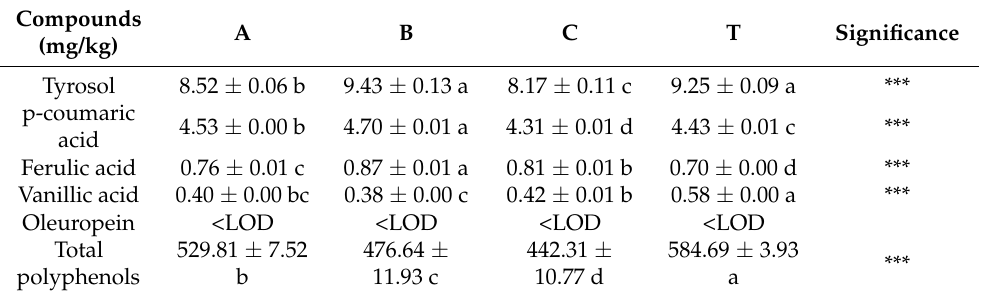
Table 6. Polyphenols content of analyzed oils treated with three biostimulants: A (tropical plants extract), B (glycine betaine), and T ( Trichoderma ) all compared with C (control). Compounds A B C T Significance (mg/kg) Tyrosol 8.52 ± 0.06 b 9.43 ± 0.13 a 8.17 ± 0.11 c 9.25 ± 0.09 a *** p-coumaric 4.53 ± 0.00 b 4.70 ± 0.01 a 4.31 ± 0.01 d 4.43 ± 0.01 c *** acid Ferulic acid 0.76 ± 0.01 c 0.87 ± 0.01 a 0.81 ± 0.01 b 0.70 ± 0.00 d *** Vanillic acid 0.40 ± 0.00 bc 0.38 ± 0.00 c 0.42 ± 0.01 b 0.58 ± 0.00 a *** Oleuropein <LOD <LOD <LOD <LOD Total 529.81 ± 7.52 476.64 ± 442.31 ± 584.69 ± 3.93 polyphenols b 11.93 c 10.77 d a